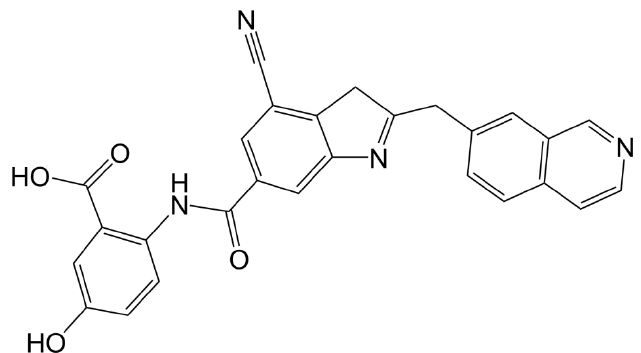
Figure 4. 2D structure of D1